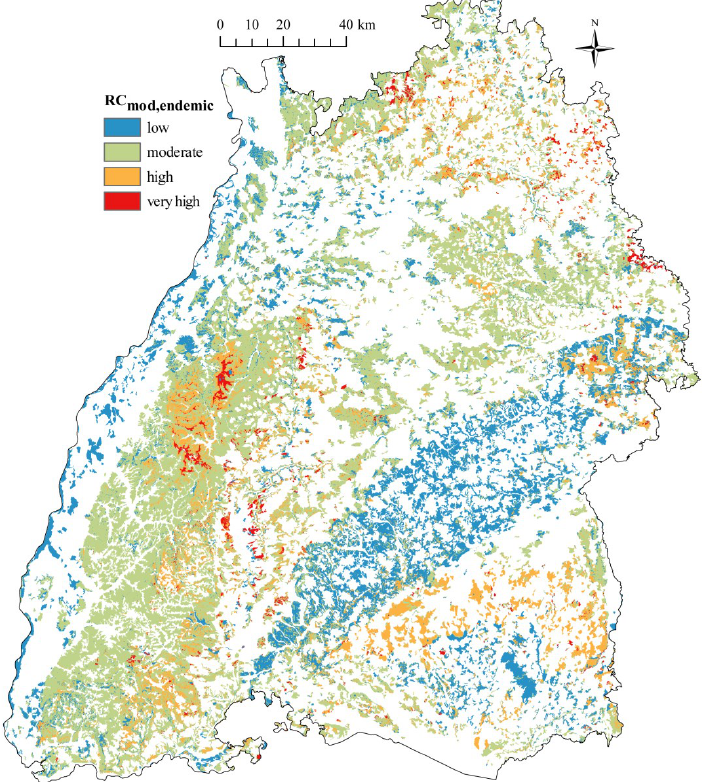
Figure 18. Map of modeled endemic storm damage risk ( RC mod,endemic ).